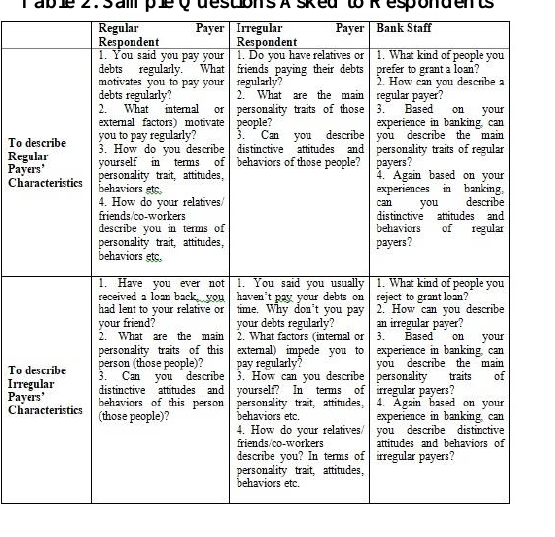
Table 2. Sample Questions Asked to